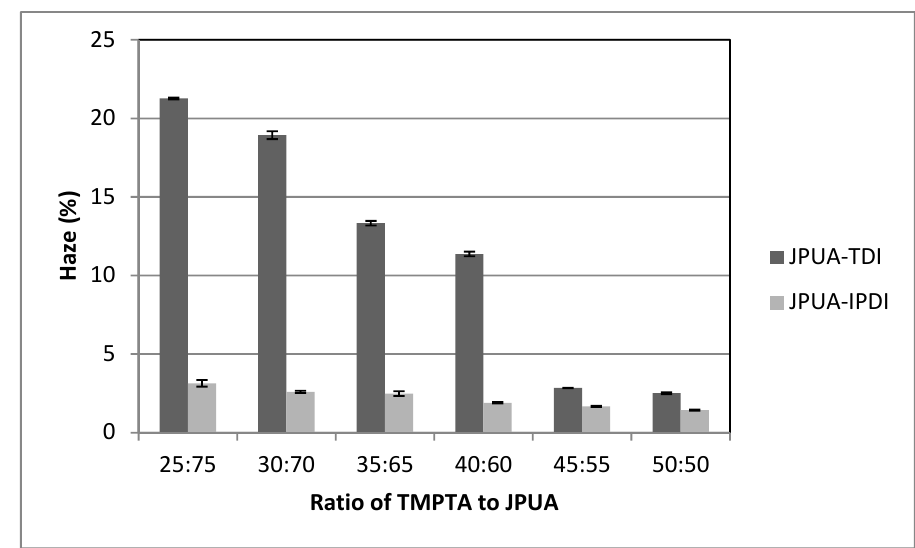
16 of 19 Figure 8. Transmittance value for variation of JPUA-TDI and JPUA-IPDI films. 3.6.5. Haze Test Haze is defined as the cloudy appearance of a material because of the light scattering of an imperfect surface. Several factors have been identified to affect the haze property such as poor dispersion, the coating technique, curing method, types of materials and additives and surface treatment. From Figure 9, JPUA-IPDI maintained a low haze for all TMPTA ratios with haze values of